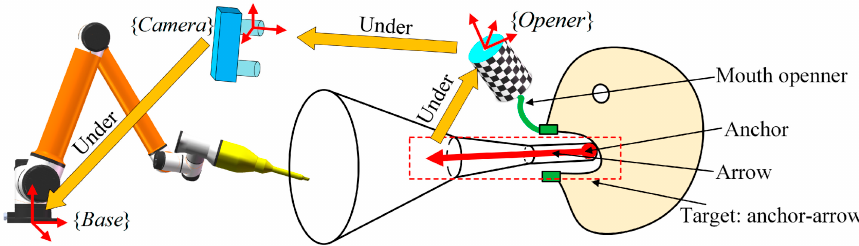
Figure 13. Correction of guiding cone can be determined by an “anchor-arrow” description.